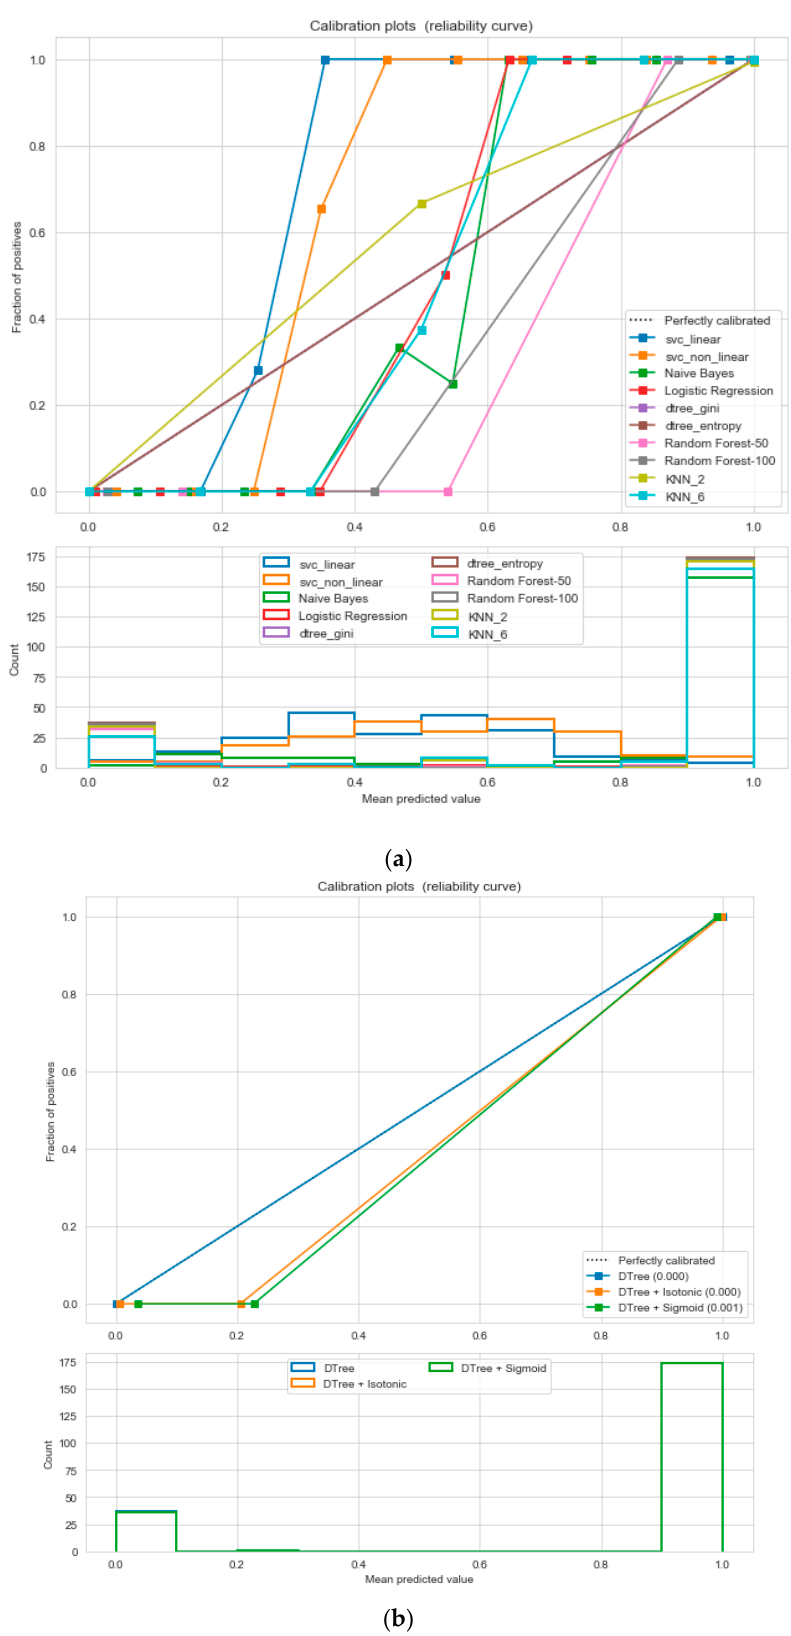
Figure 12. ( a ) Reliability curve to classify “Insurance” data with different ML classifiers. ( b ) Reliability curve to classify “Insurance” data with the “Calibrated Decision Tree”.